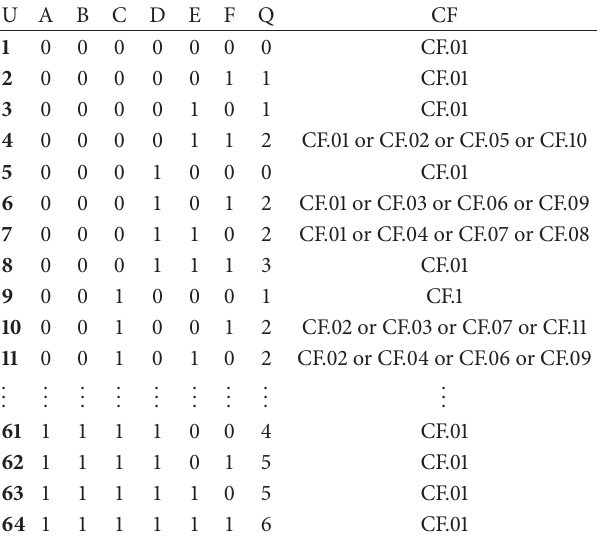
Table 2: Part of the Information System of a 3 × 2